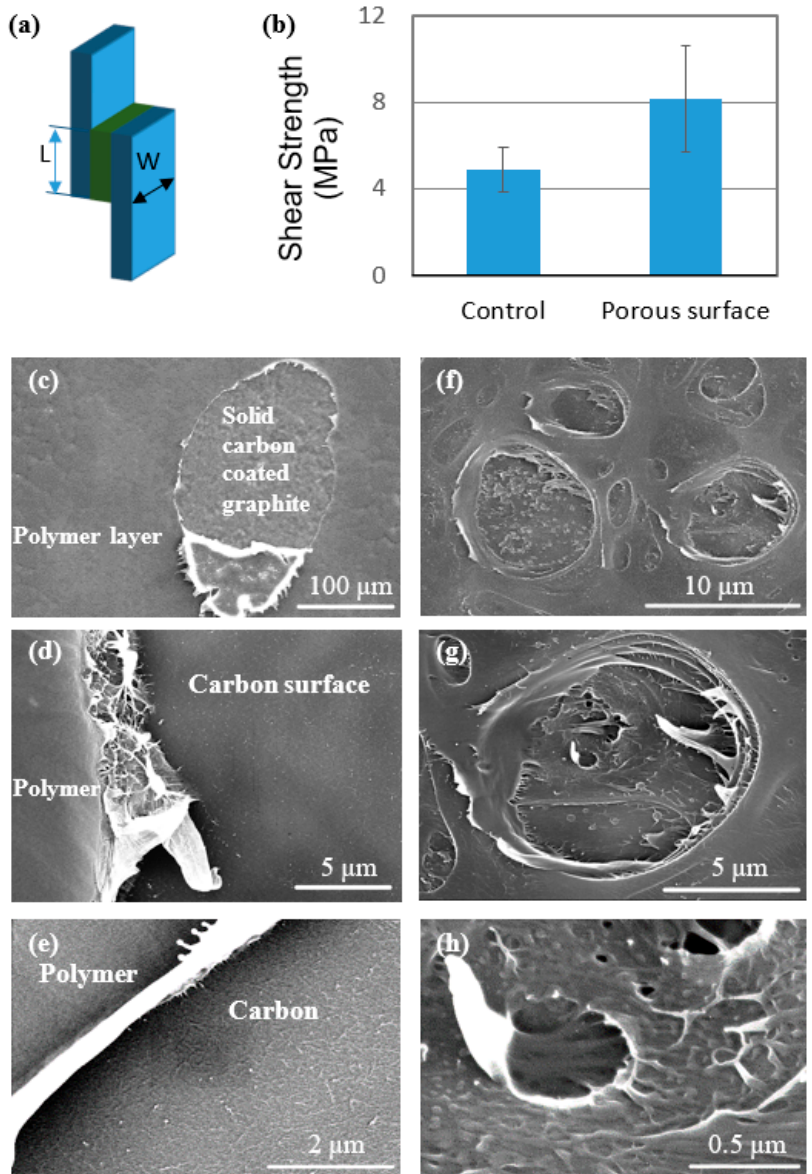
Figure 7. The schematic of the single lap-joint specimen ( a ), the shear strength results ( b ), and the SEM micrographs showing the fracture surfaces of solid ( c , d , e ) and porous ( f , g , h ) carbon-coated graphite plates.